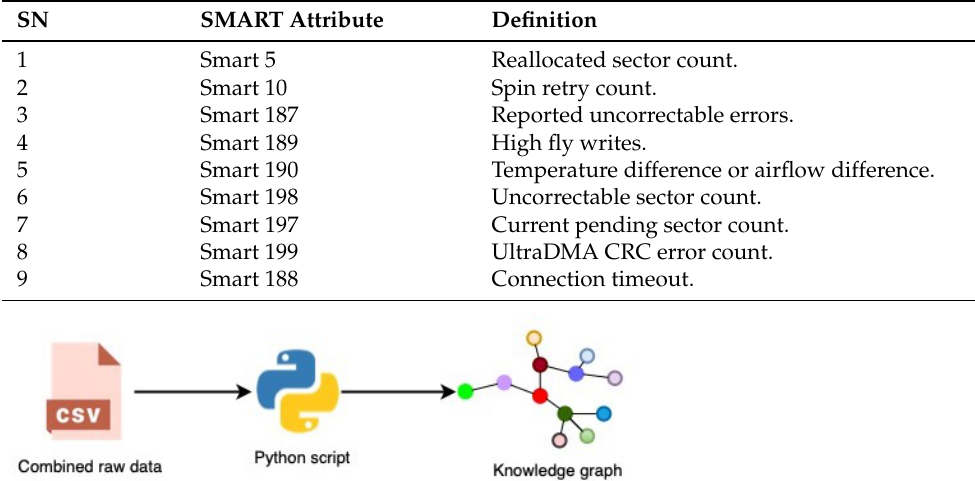
Table 2. List of used SMART attributes and their definitions.